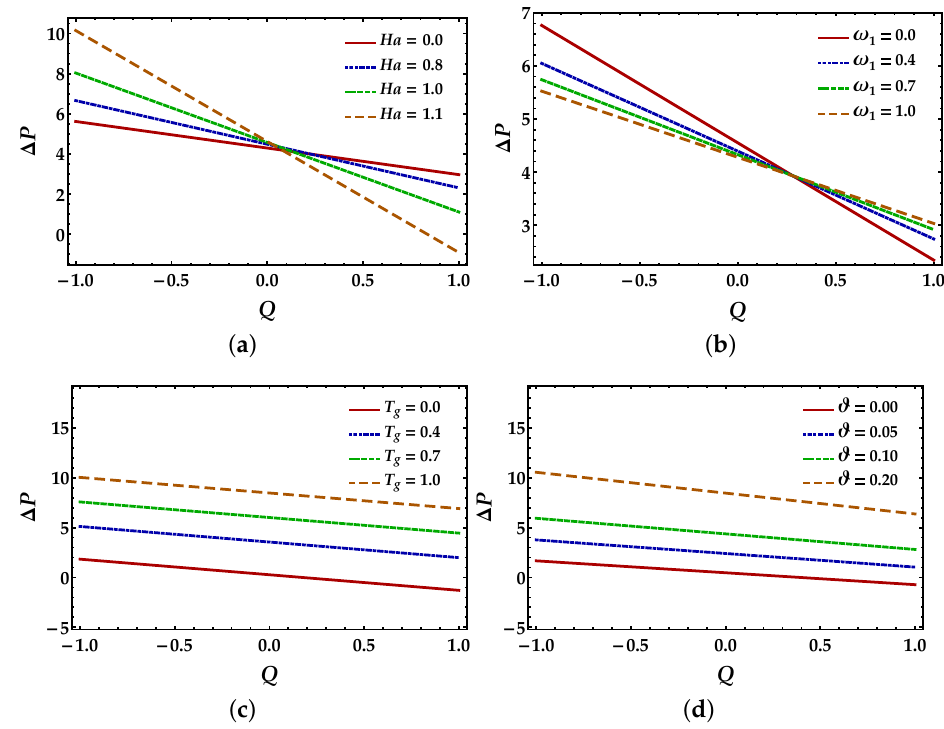
Figure 3. Pressure rise versus volumetric flow rate against multiple values of different parameters. ( a ) Ha , ( b ) ω 1 , ( c ) T g , ( d ) ϑ